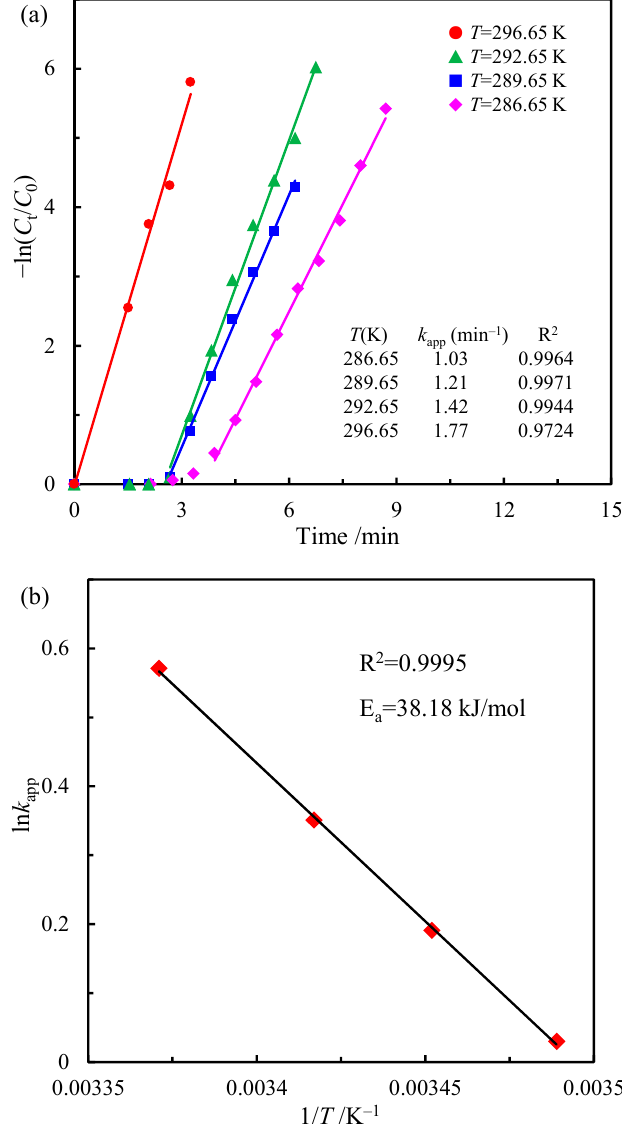
Figure 7. ( a ) Plots of − ln (C t /C 0 ) versus the reduction time for the catalytic p-NP reduction at different temperatures over CoOOH/rGO. ( b ) The corresponding Arrhenius plot at different temperatures.